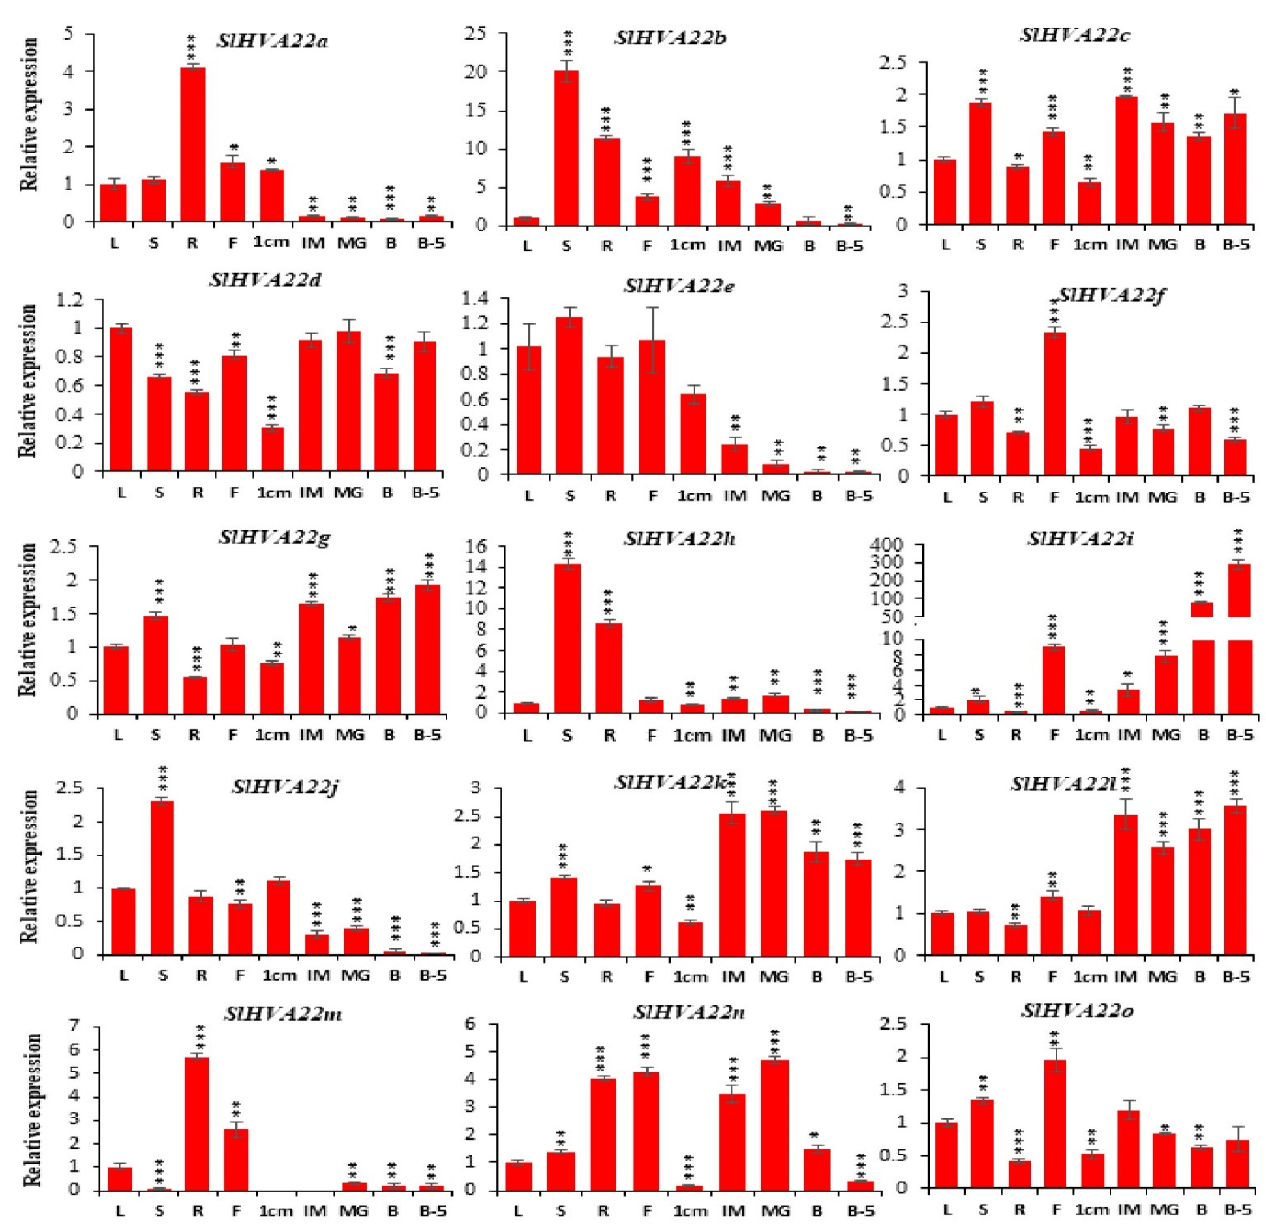
Figure 8. Expression profiles of SlHVA22 genes in various organs: leaves, roots, stems, flowers, 1 cm fruits, immature fruits (IM), mature green fruits (MG), breaker fruits (B), and fruits 5 days after the breaker stage (B5). The standard deviations of the means of three independent biological replicates are represented by the error bars. The different asterisks above the bars denote the significant variations between the control samples (leaves) and the samples harvested from the other organs, as analyzed by Student’s t -test with p -values less than 0.05 for *, 0.01 for **, and 0.001 for ***,